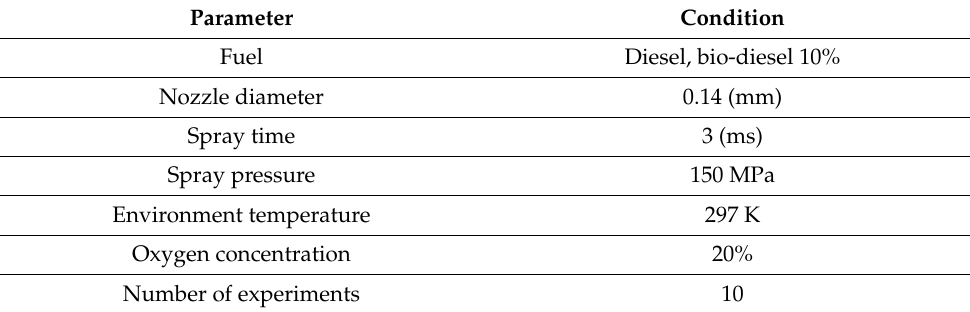
Table 5. Experimental conditions.